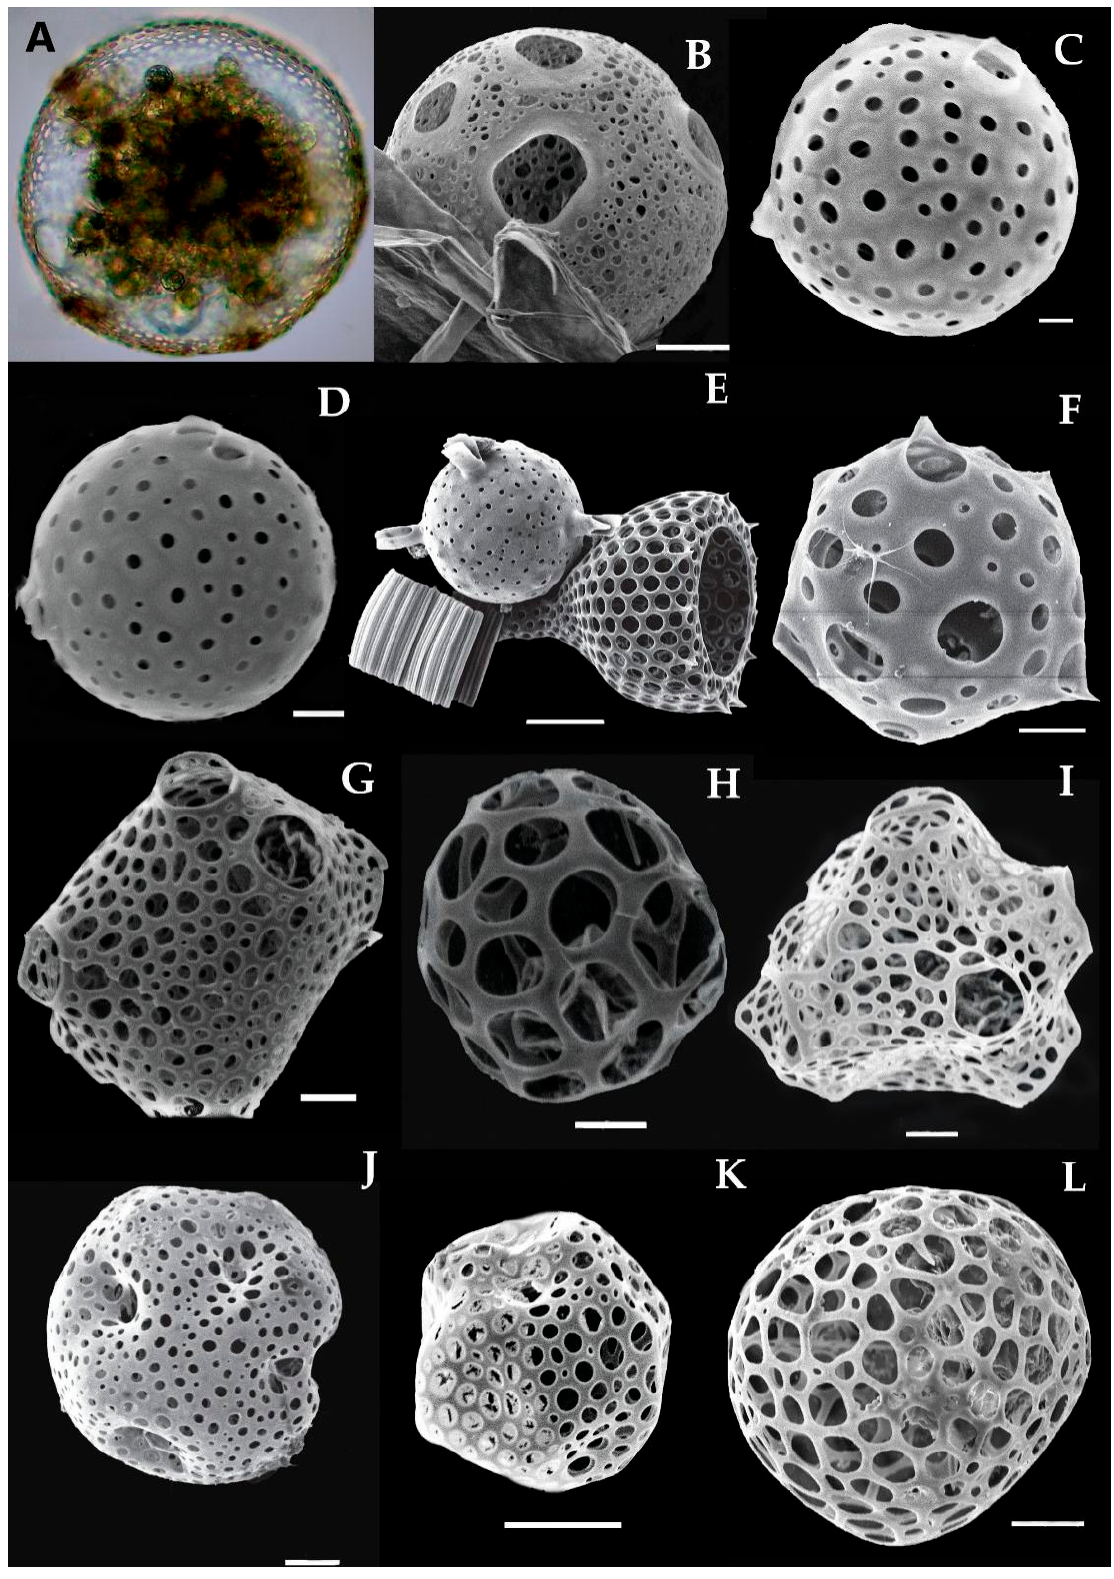
Figure 4. Light and scanning electron micrographs of collosphaerea and siphonsphaera species in the eastern Indian Ocean. Images were reused from Munir et al. [27]. ( A , B ) Siphonosphaera magnisphaera has large pores shell. ( C , D ) Siphonosphaera polysiphonia ( E ) Siphonosphaera socialis, ( F – J ) Collosphaera macropora, ( I ) Disolenia zanguebarica, ( K ) Collosphaera tuberosa, and ( L ) Collosphaera huxleyi. Scale bars 10, 20 and 50 µm.